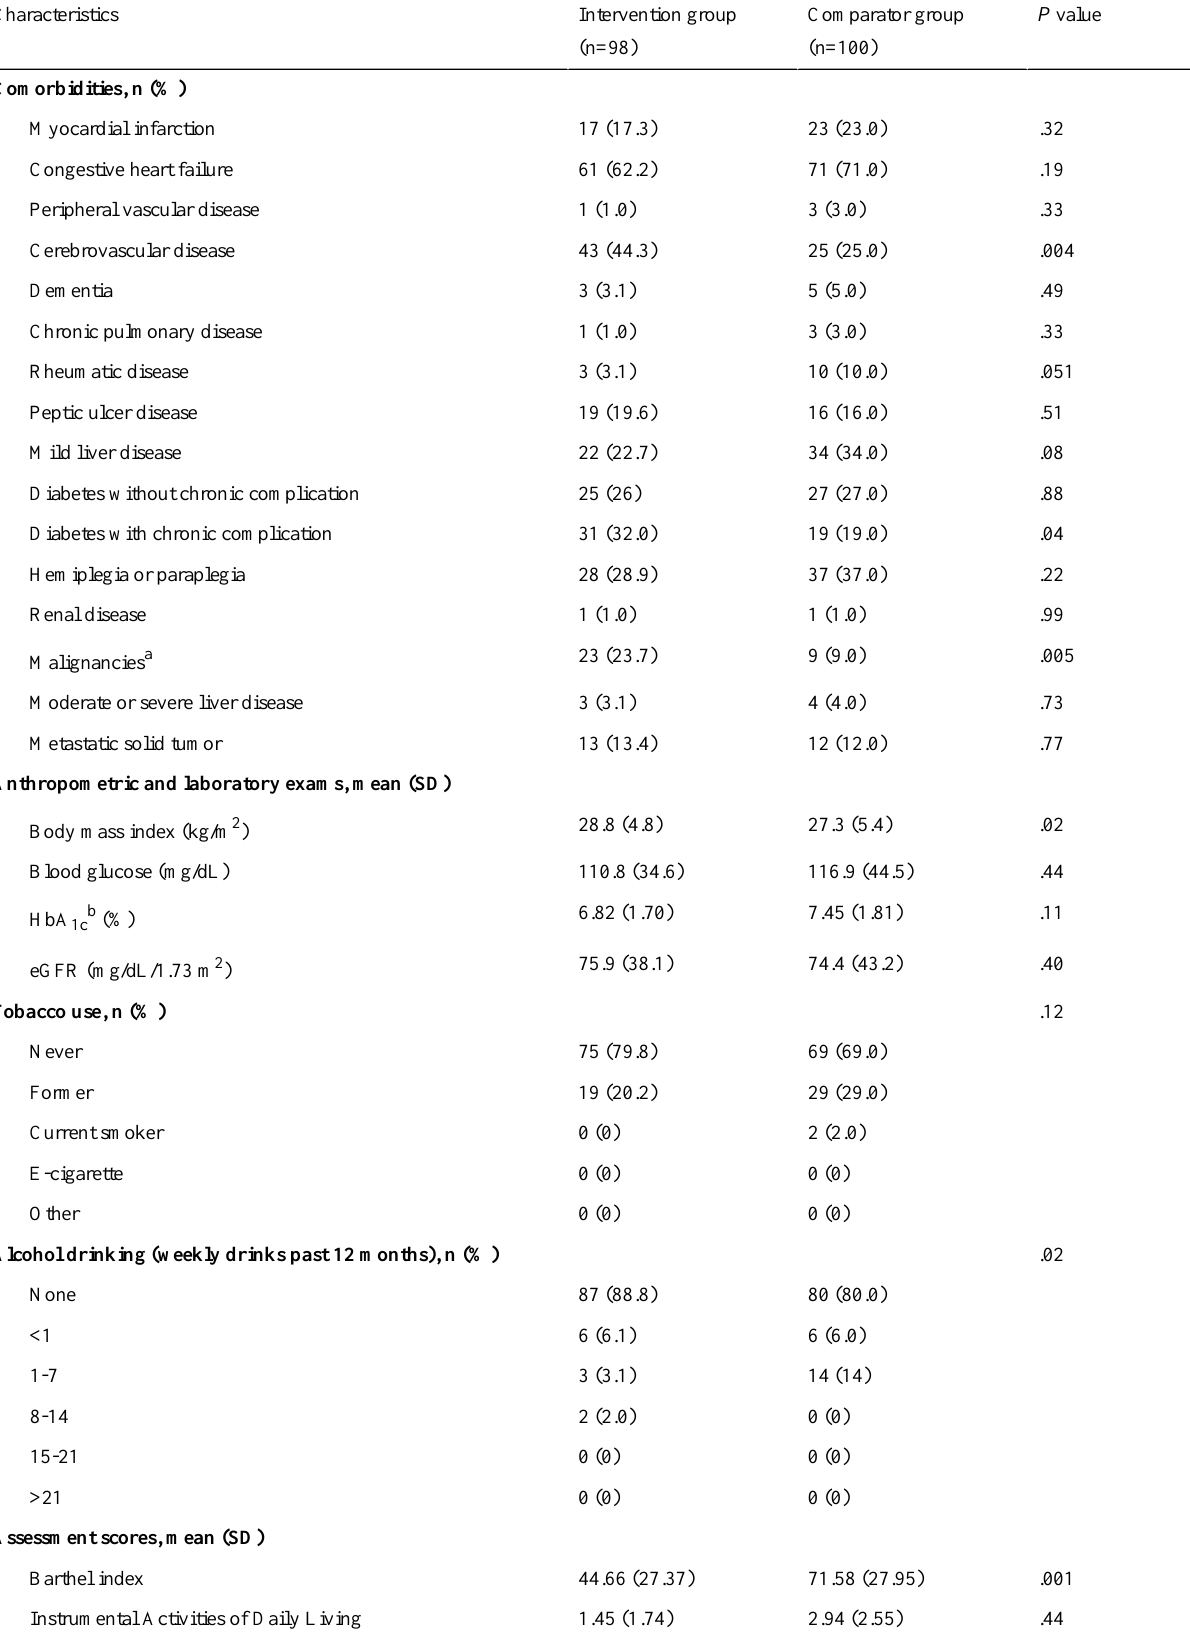
Table 2. Clinical characteristics of study participants at baseline